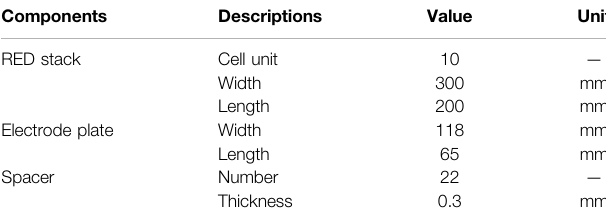
TABLE 2 | Principal structure of the RED stack.